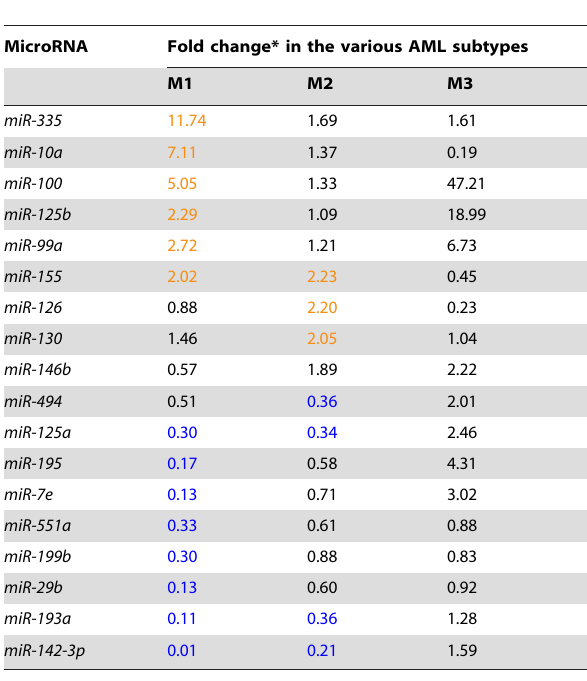
Table 4. Differentially expressed microRNAs in the French- American-British (FAB) classification of